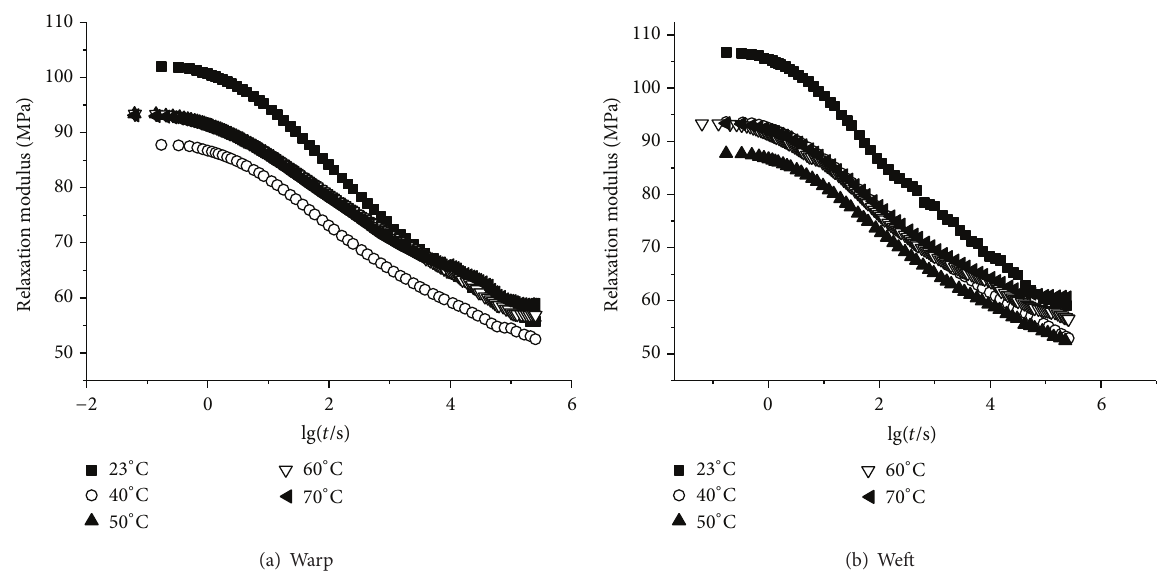
Figure 7: Relaxation modulus of PTFE coated fabrics under different